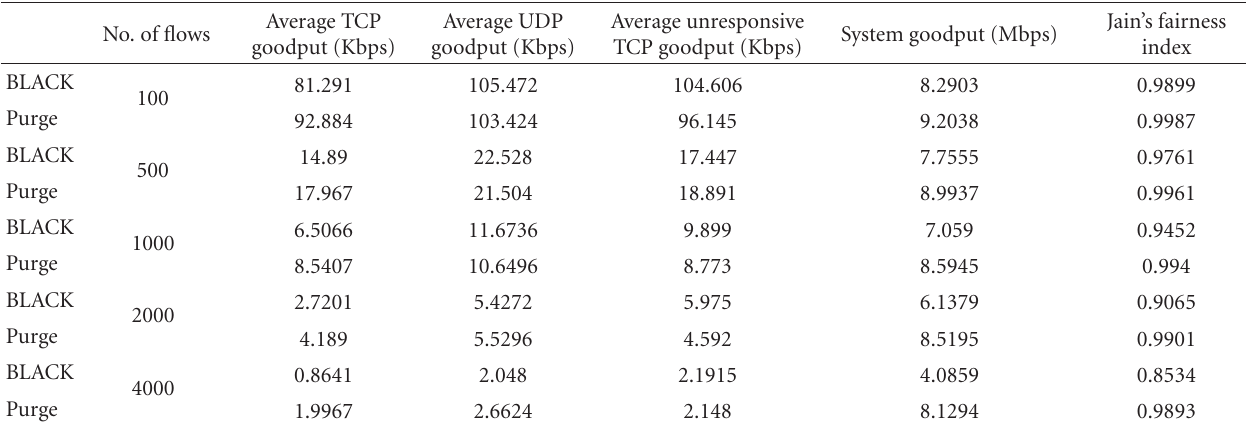
Table 3: Goodput in multiple unresponsive flows